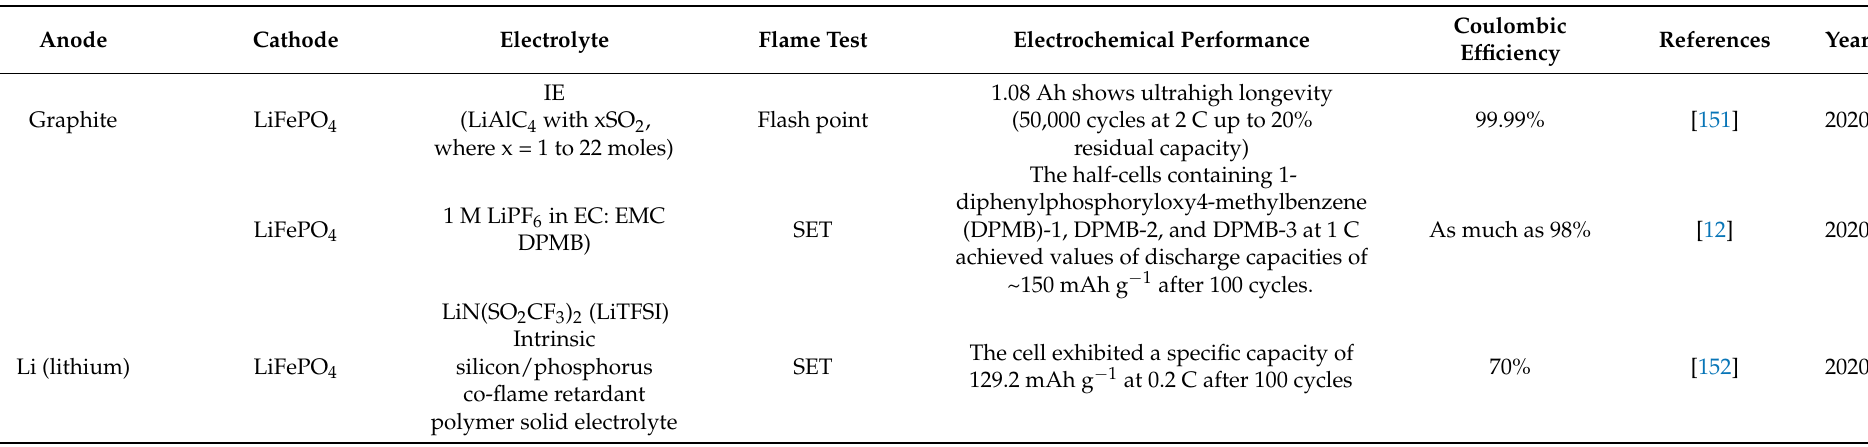
Table 9. Flammability and electrochemical performance of different electrolytes systems and different additives used for electrolytes in LIBs in the years 2001–2020.